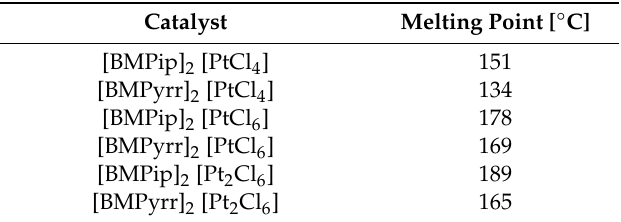
Table 1. Melting points of the synthesized chloroplatinate complexes.